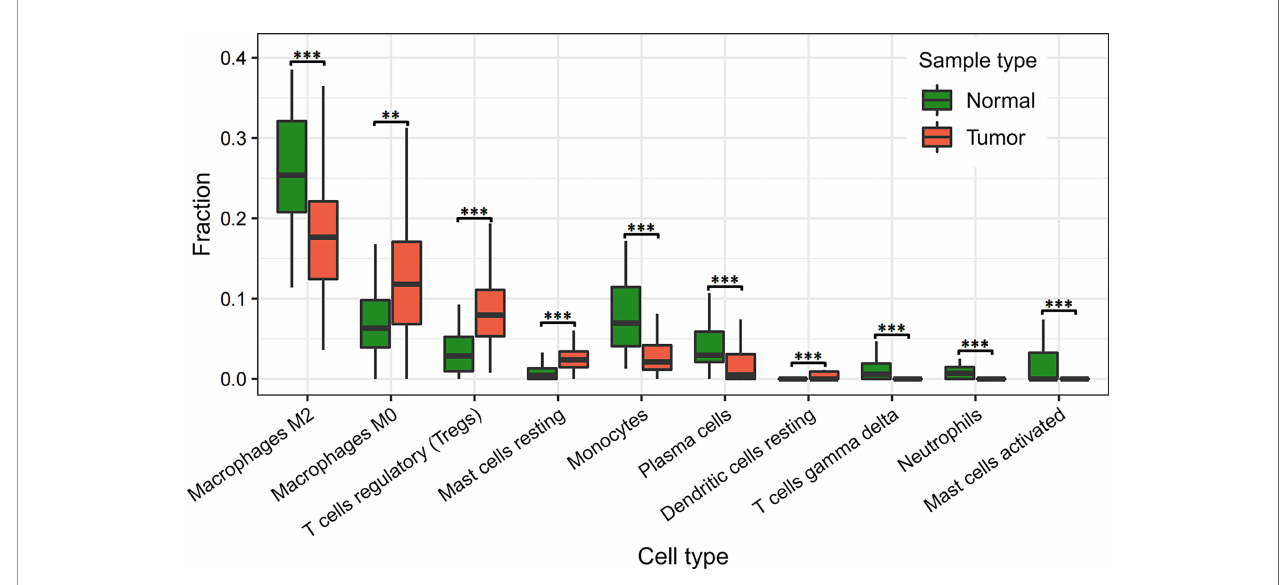
FIGURE 4 | Differetial analysis of immune cell in fi ltration in normal and tumor tissues. “ ** ” indicates FDR < 0.01; “ *** ” indicates FDR <